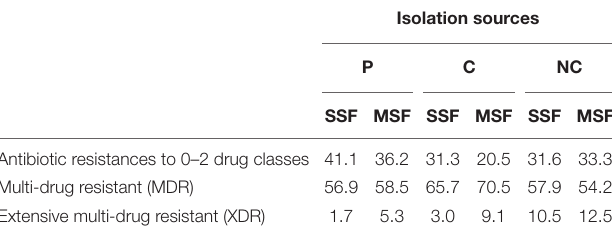
TABLE 1 | Distribution of isolates based on their resistant drug classes amongst sample